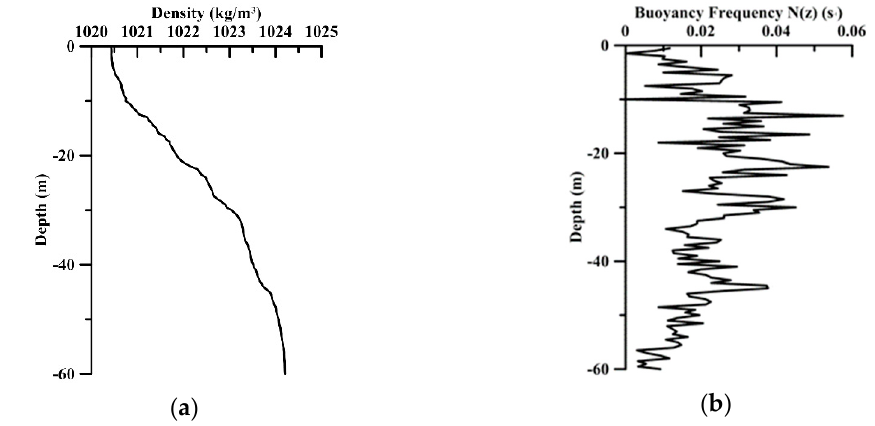
Figure 4. Mean background oceanic profiles of ( a ) density and ( b ) buoyancy frequency from CTD casts of S1 (109.8190°E, 18.1596° N) and S2 (109.9268° E, 18.1167°N).